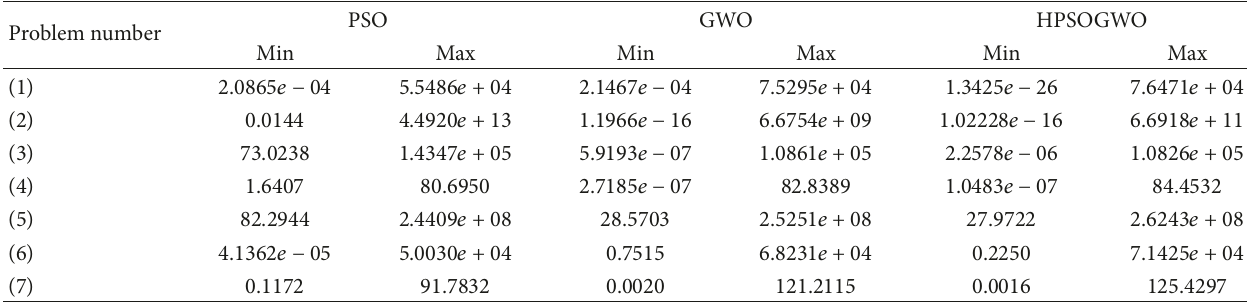
Table 4: PSO, GWO, and HPSOGWO numerical results of unimodal benchmark functions.